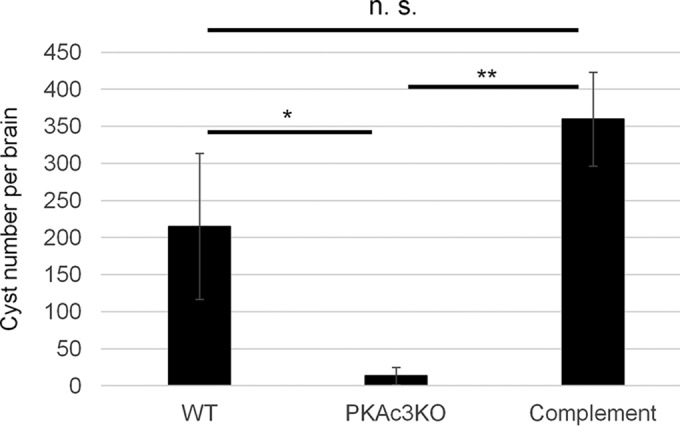
In vivo cyst production with TgPKAc3 mutant parasites. Six- to 8-week-old female C57BL/6J mice were infected with 10,000 parasites via the intraperitoneal route. Seven weeks after infection, the tissue cyst number in the infected mouse brain was counted. The average numbers of cysts and standard deviations (n = 4 for wild type [WT], n = 3 for knockout [KO], and n = 4 for complemented) are shown. Mean values were statistically analyzed with one-way analysis of variance for detecting a difference in the groups and with a post hoc Tukey honestly significant difference test for pairwise comparison. n.s., P > 0.05; *, P < 0.05; **, P < 0.01.